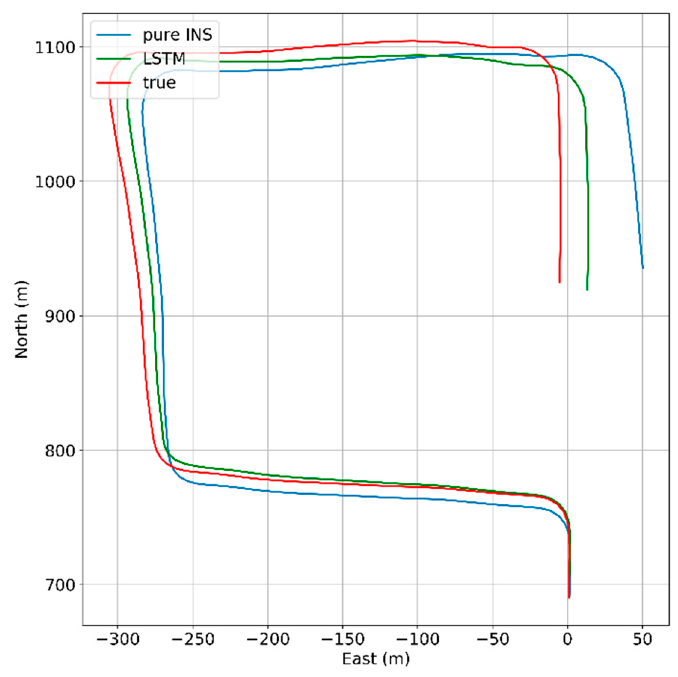
Figure 18. Heading errors of 120 s outages with different algorithms.